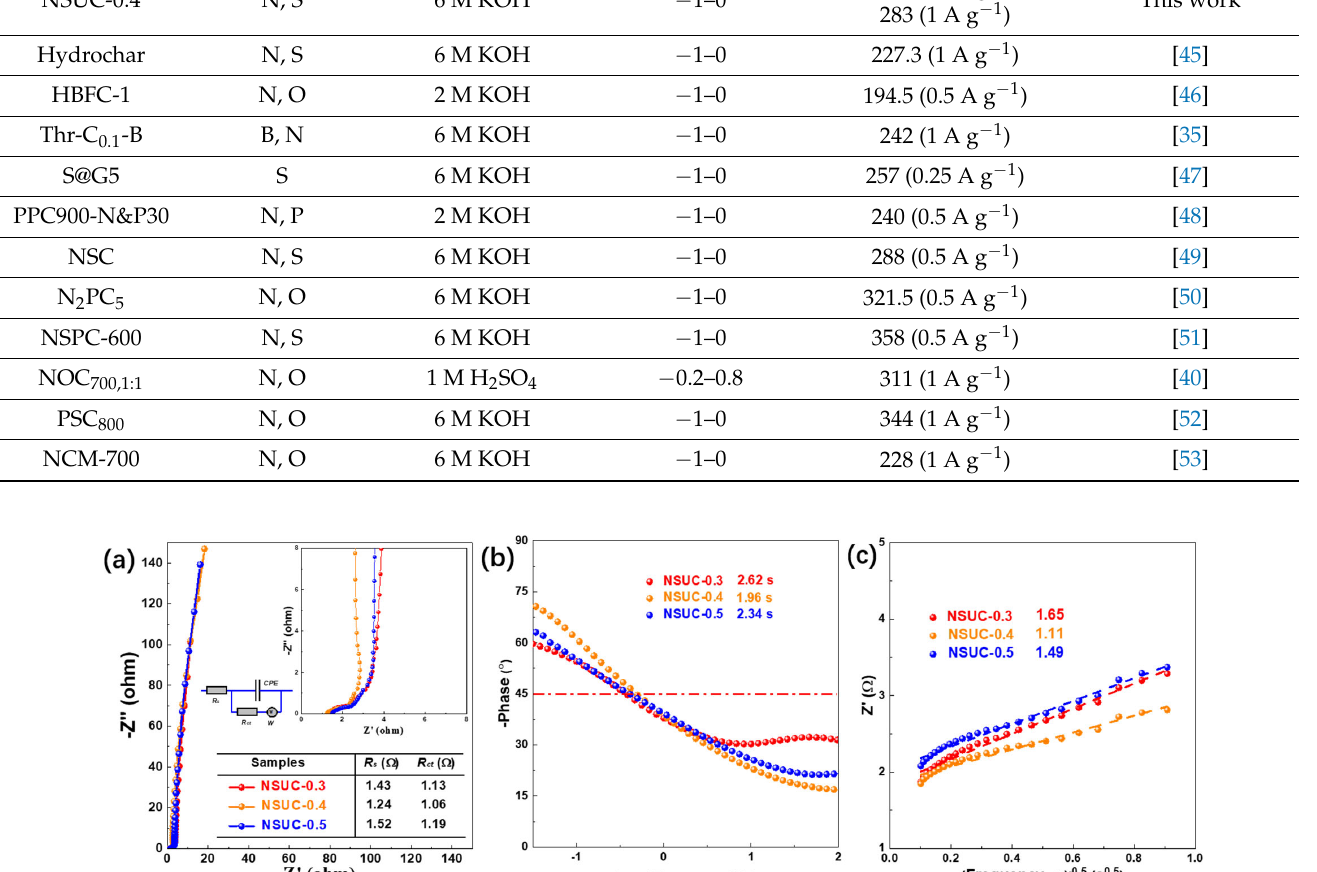
Figure 7. ( a ) Nyquist plots, ( b ) Bode plots and ( c ) Randles plots of NSUC ‐ x.